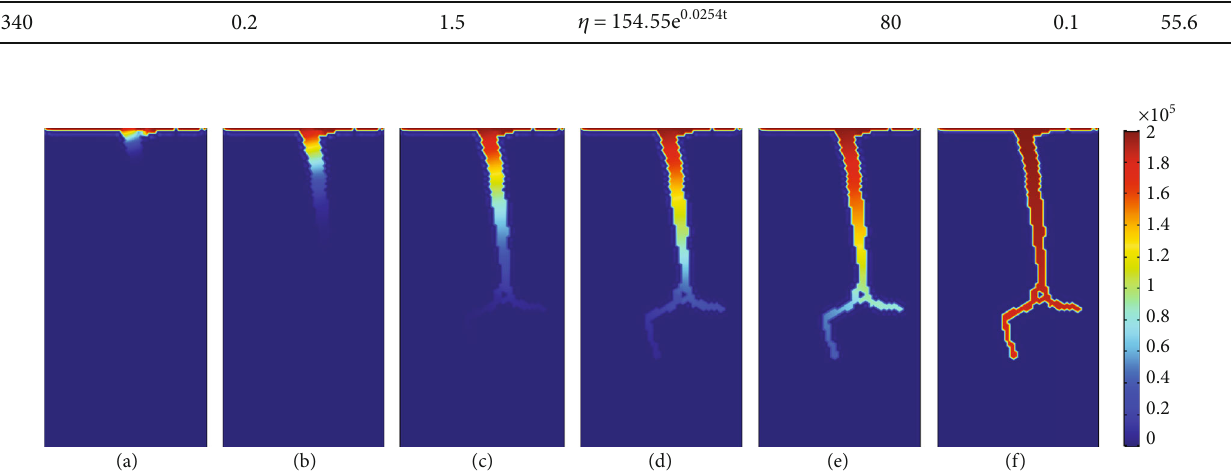
Figure 11: Cloud map of the variation of grouting pressure distribution with time (coal sample 1#). (a) t = 1s . (b) 10s. (c) 50s. (d) 100 s. (e) 200s. (f) 2000 s.